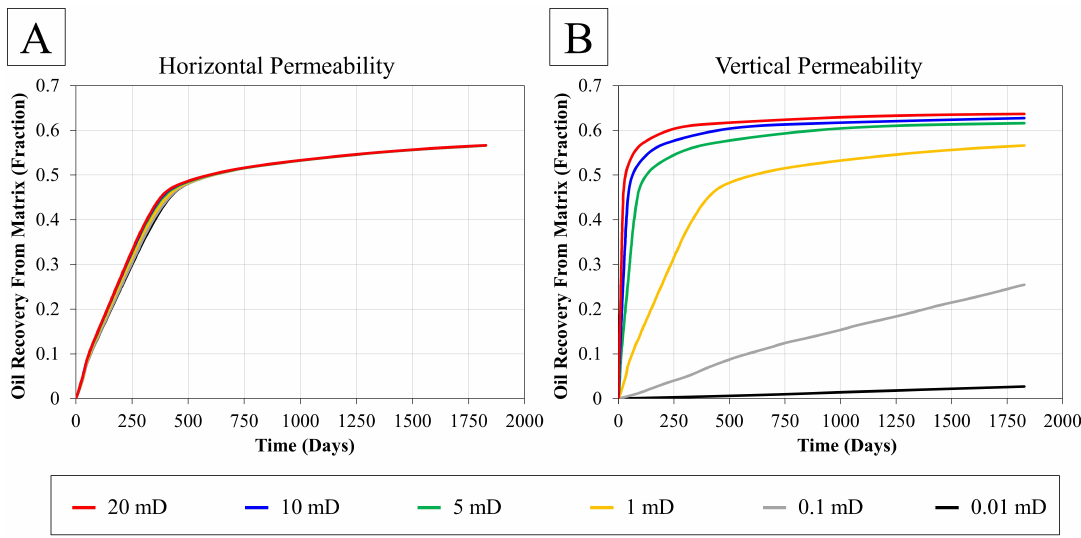
Figure 14. Comparison of the matrix permeability effect on the recovery speed and oil recovery from matrix blocks ( A ) horizontal permeability in both x- and y-direction; ( B ) vertical permeability in the